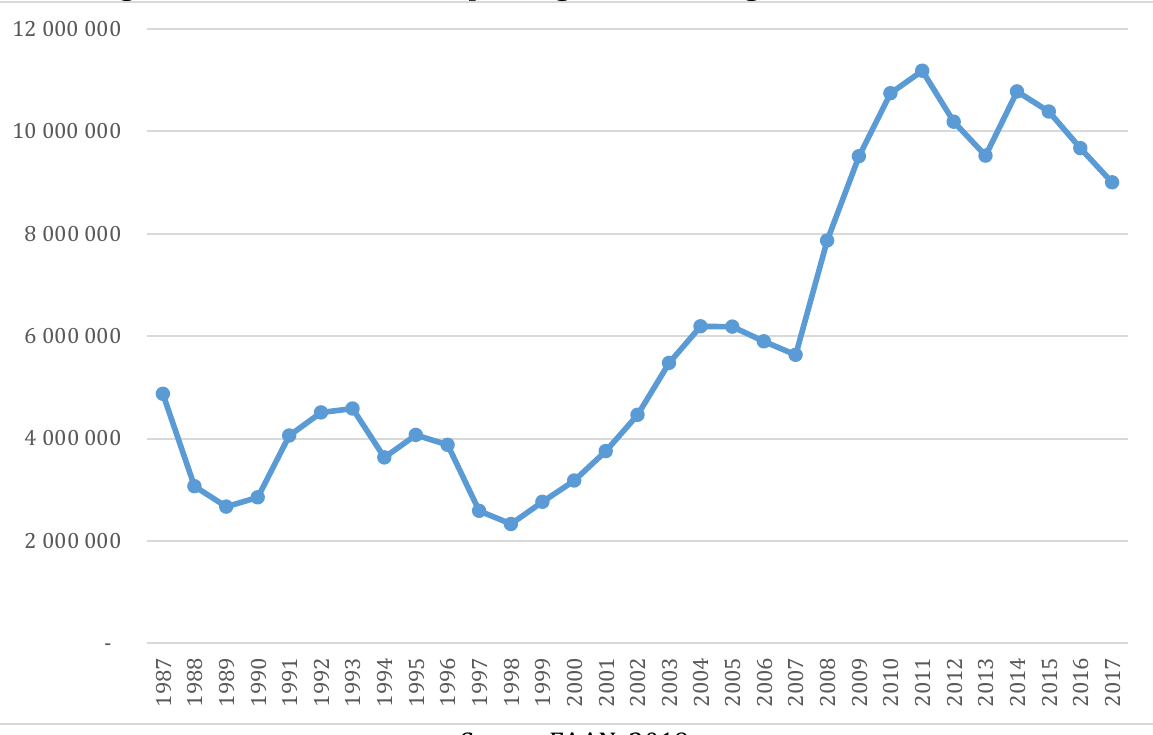
Figure 2: Pattern of domestic passenger traffic in Nigeria from 1987 to 2017